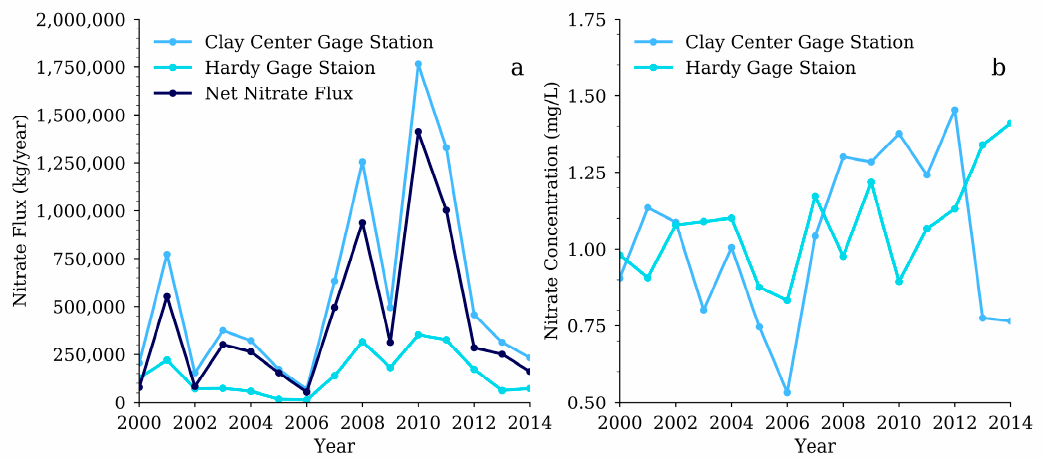
Figure 6. ( a ) Nitrate flux estimated for the two USGS gage stations, Hardy and Clay Center and the gage stations; ( b ) The annual average nitrate concentrations (mg/L) estimated by the LOADEST model